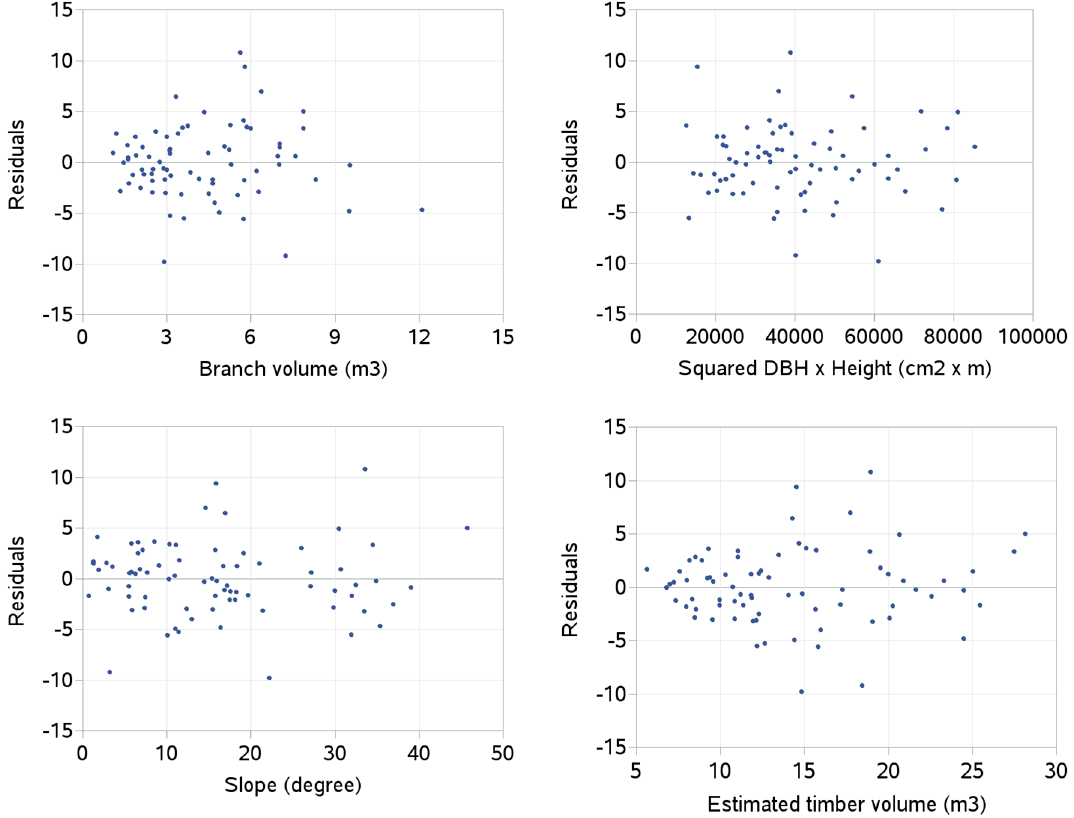
Figure 5. Residuals against predictor variables and estimated timber volume with a timber prediction model (Equation 3).